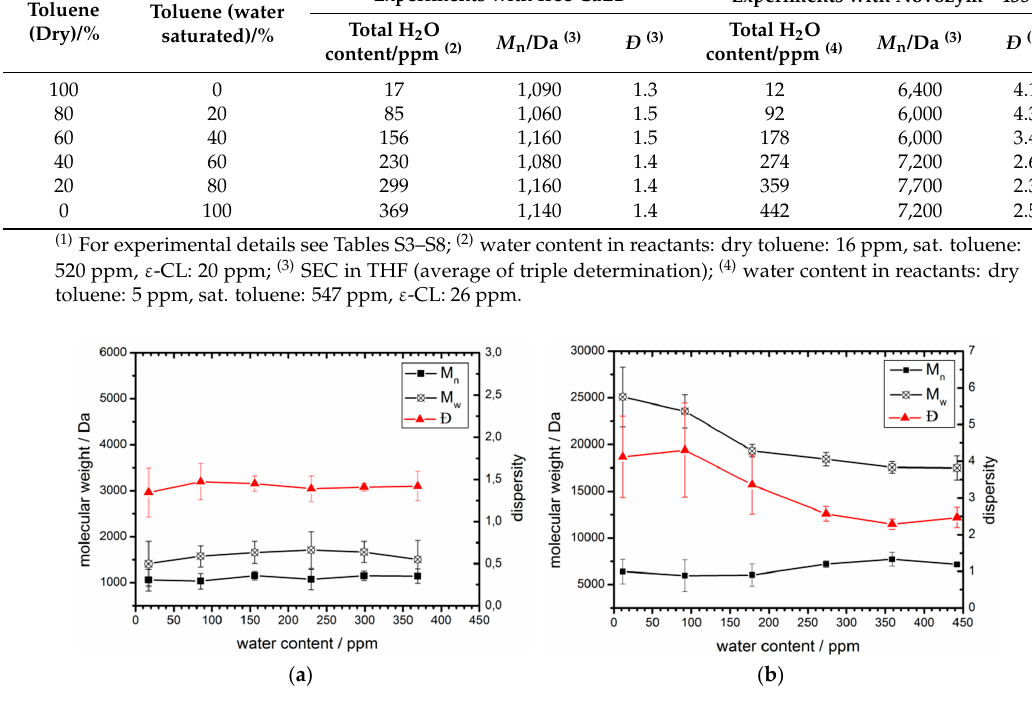
Table 2. Enzymatic ROP of ε -CL in toluene with varying water content using free CaLB and Novozym ® 435 as catalyst (1) ; results of SEC analyses. Toluene (Dry)/% Toluene (water saturated)/%